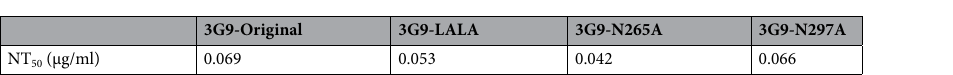
Table 4. NT 50 values of Fc-modified 3G9. Average of two independent neutralization tests is shown